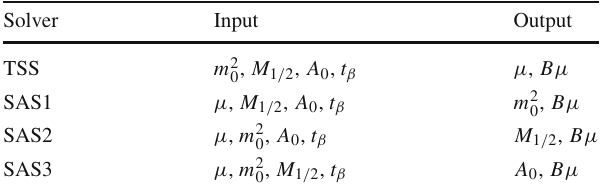
Table 1 CMSSM input/output